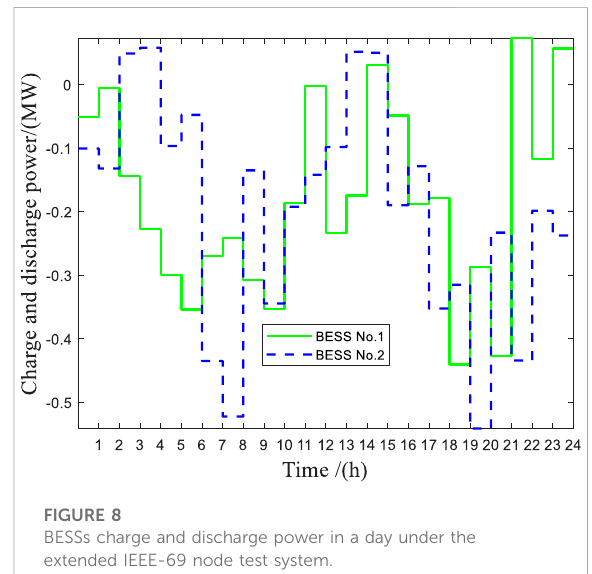
FIGURE 8 BESSs charge and discharge power in a day under the extended IEEE-69 node test system.